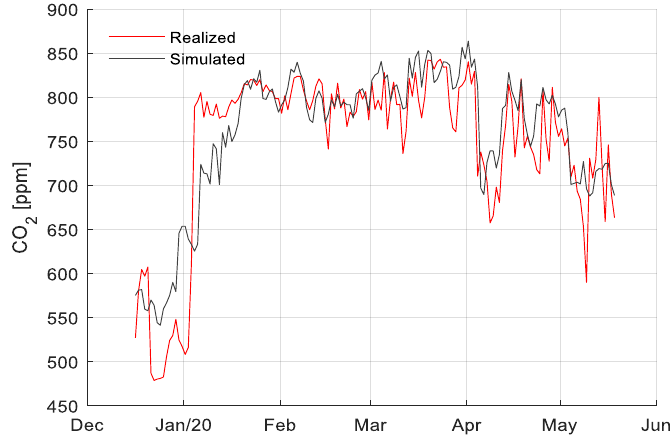
Figure A8. Measured and simulated CO 2 concentration (ppm) of the greenhouse air after automated distillation of climate strategies during the experimental period (16 December 2019 until 29 May 2020) for one of the compartments (301).